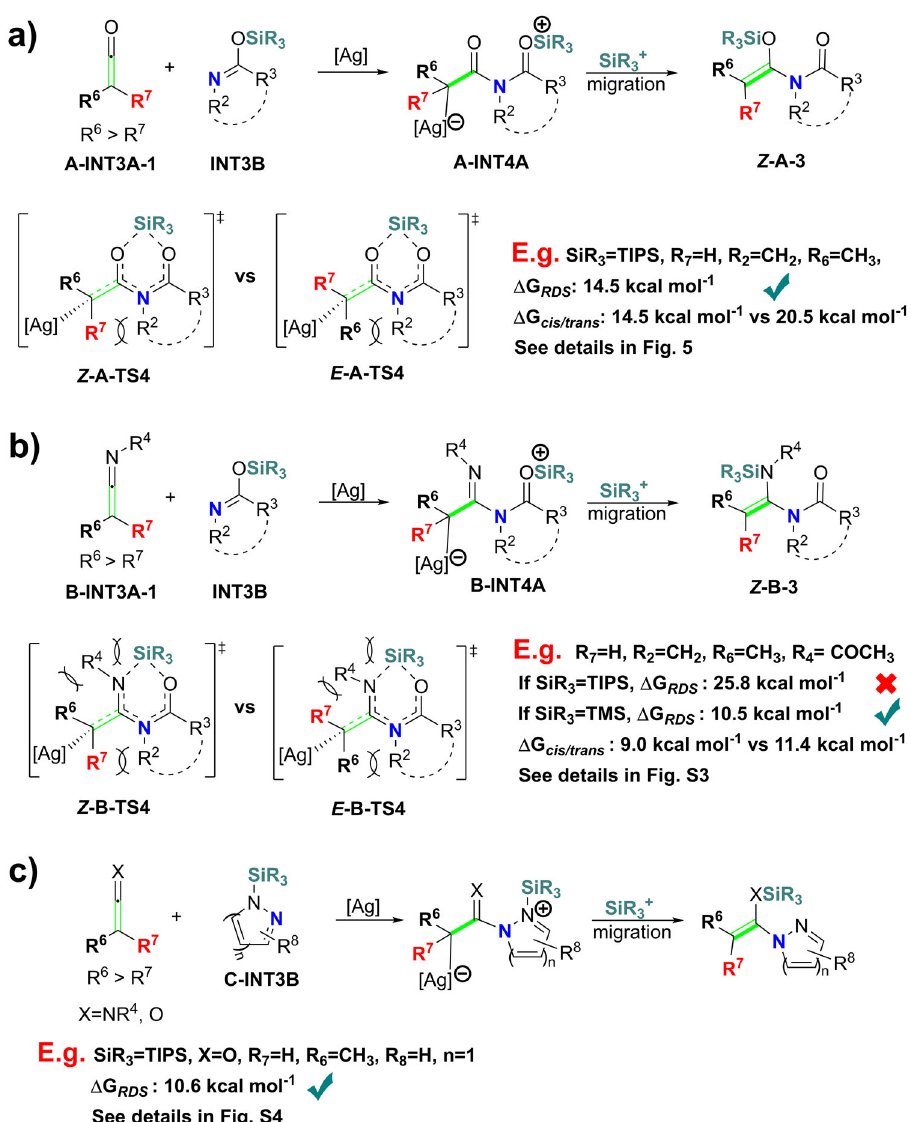
Fig. 6 Methods to obtain substituted enamides. a Substituted ketenes as substrates. b Substituted ketene-imines as substrates. c Silyl substituted p – π conjugation system as